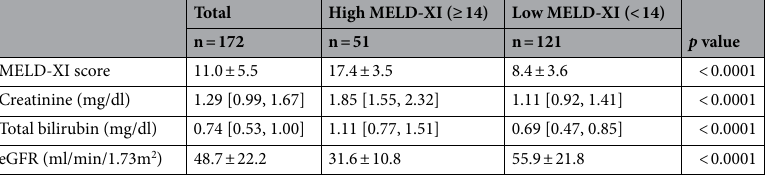
Table 4. Assessment of hepatorenal function at baseline. Values shown are either mean ± SD or median [interquartile range]. MELD-XI score Model for End-stage Liver Disease eXcluding International normalized score, eGFR estimated glomerular filtration